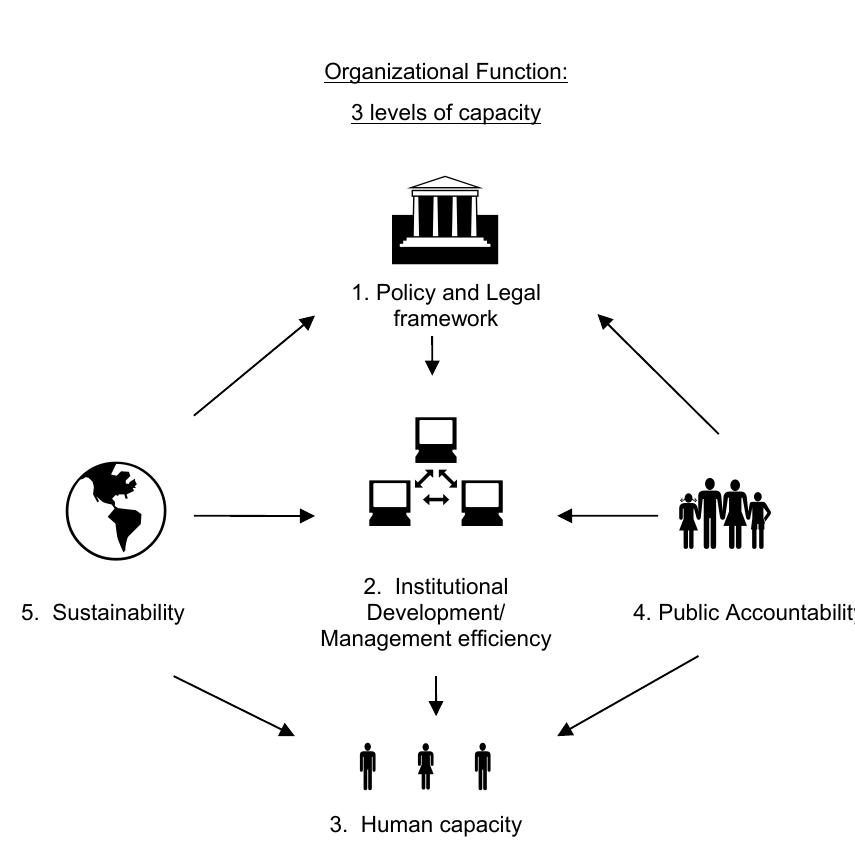
Figure: The Five Key Principles of Capacity